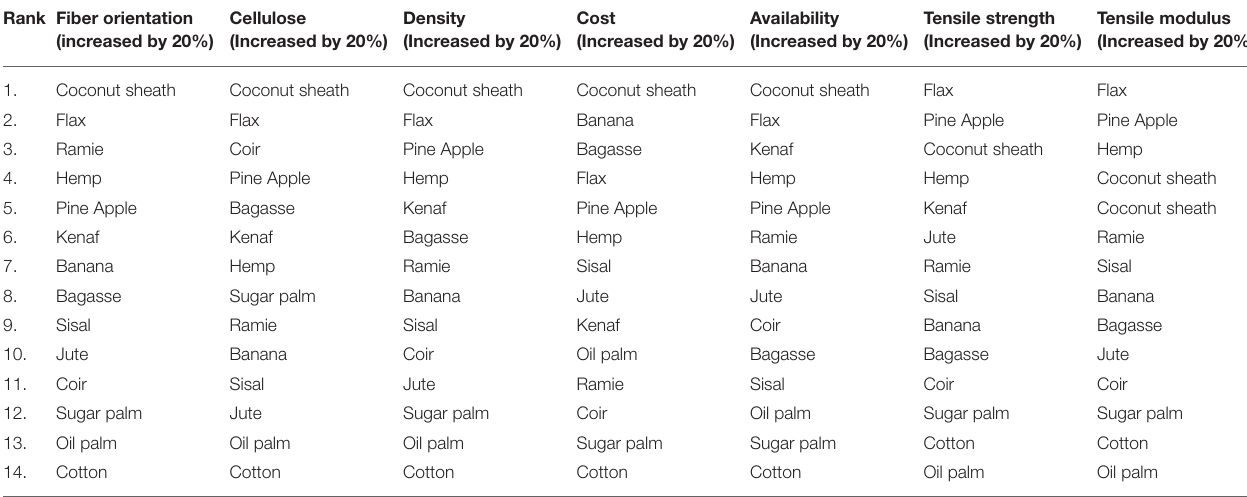
TABLE 5 | Overall rank when priority vector of individual criteria is increased by